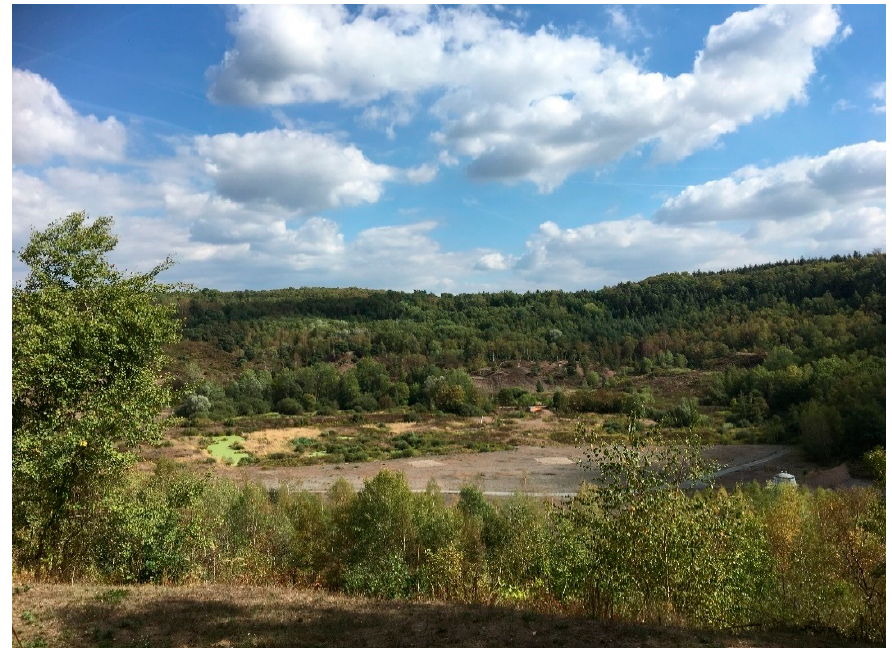
Figure 17. Messel Pit WHS open-cast mine—mining has exposed the form of the ancient maar volcano crater.